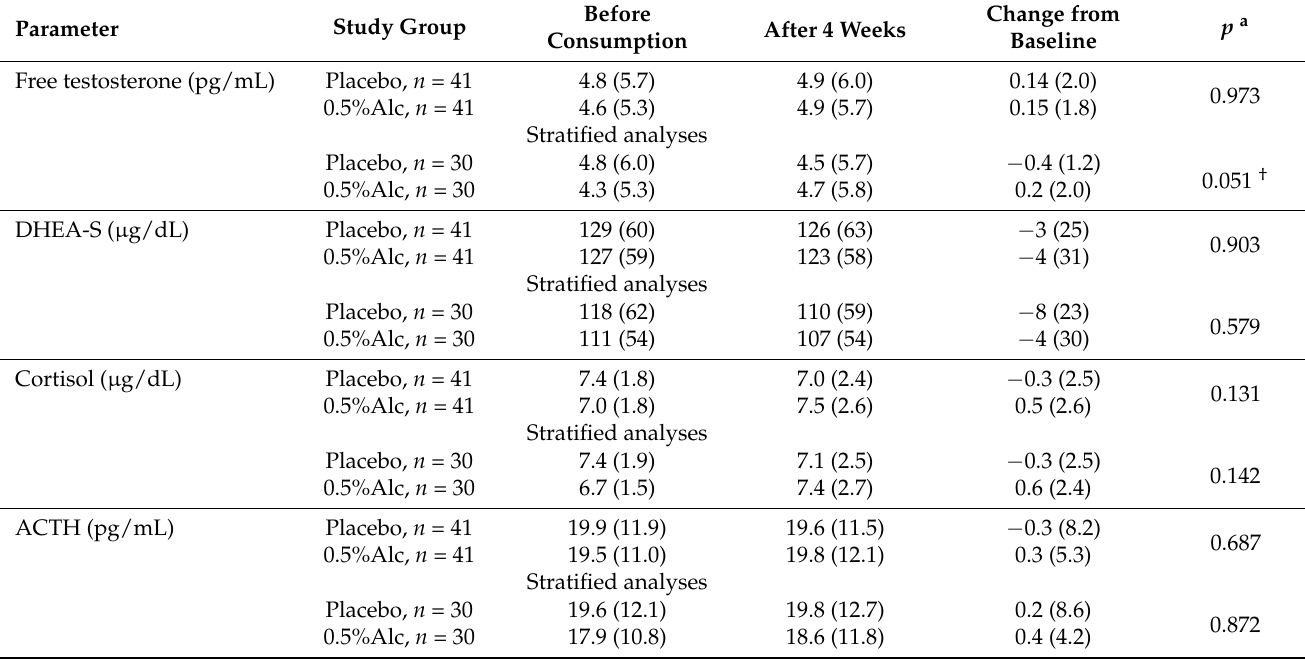
Table 4. Comparative results for endocrinological parameters between the study